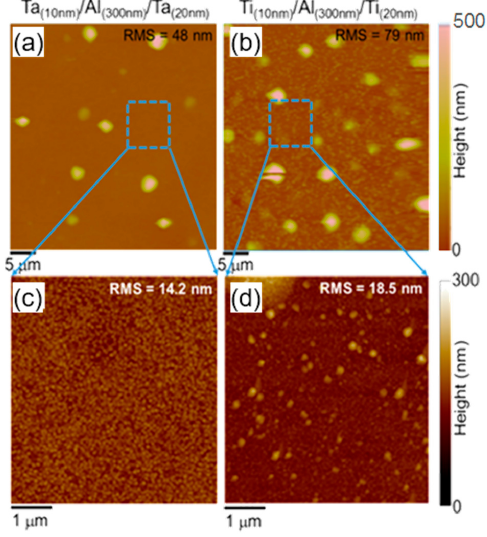
Figure 3. Atomic Force Microscopy (AFM) images of contacts on AlGaN/GaN heterostructure: ( a ) AFM images of Ta/Al/Ta contact on 40 µm × 40 µm and ( b ) 5 µm × 5 µm scan areas, and ( c ) AFM images of Ti/Al/Ti contact on 40 µm × 40 µm and ( d ) 5 µm × 5 µm scan areas, after annealing at 600 °C.